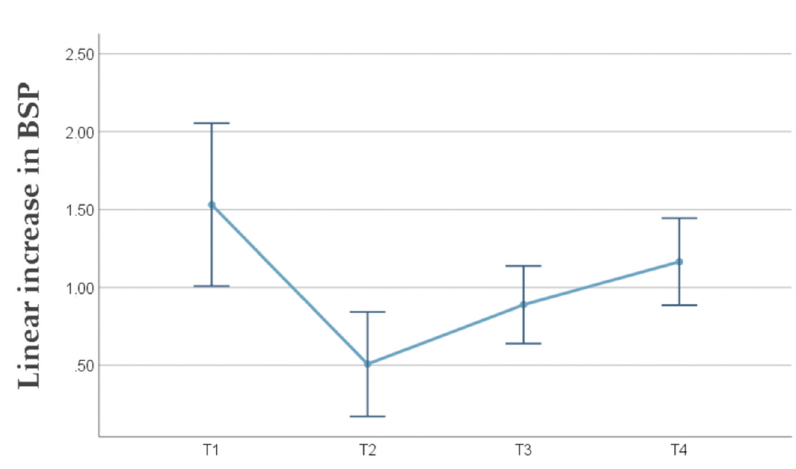
Figure 4. Line chart with the mean linear increase in buccal soft tissue profile (BSP) and 95% confidence interval (CI) at the different time points.